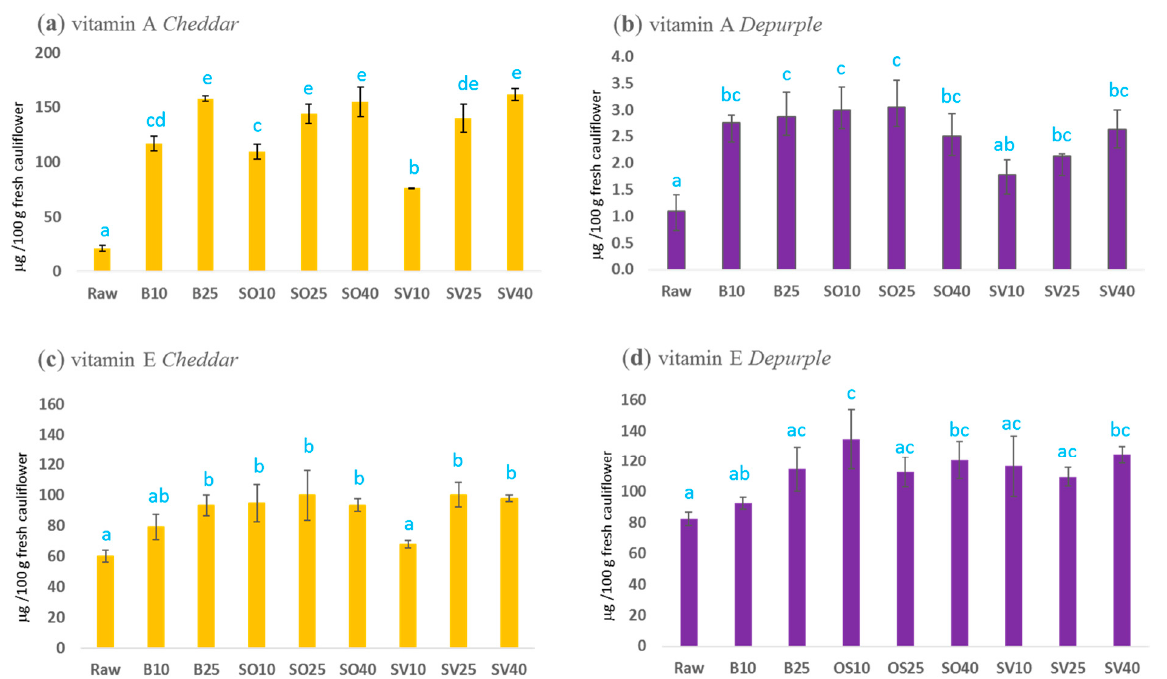
Figure 2. Vitamin A and E contents ( μ g/100 g fresh cauliflower) in raw and cooked samples. ( a ) Vitamin A quantified in Cheddar cauliflower. ( b ) Vitamin A in Depurple cauliflower. ( c ) Vitamin E in Cheddar variety. ( d ) Vitamin E in Depurple cauliflower. Data are expressed as mean of three replicates ± standard deviation (SD). Different superscript letters (a-e) mean significant statistical difference ( p < 0.05, one-way ANOVA).